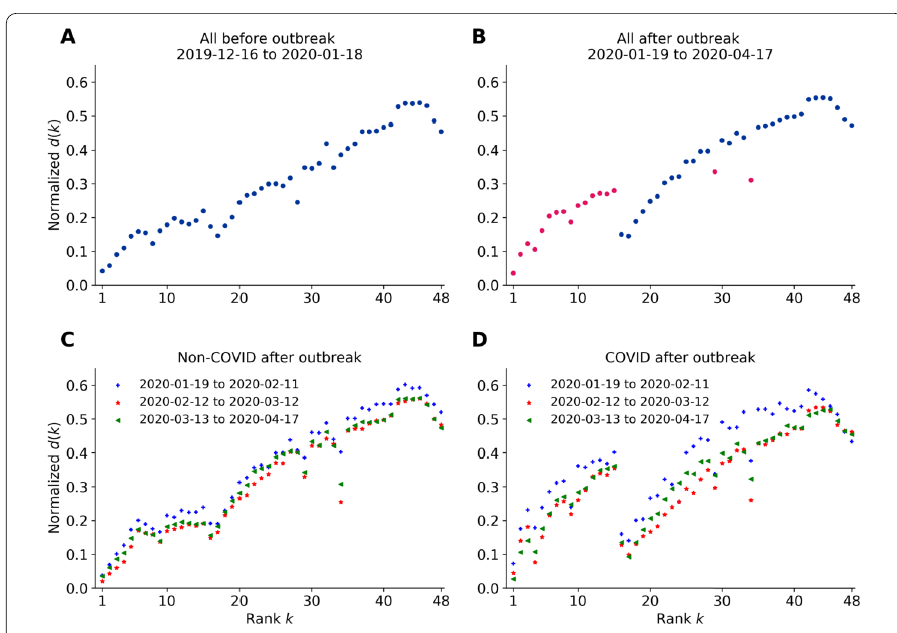
Figure 4 Rank diversity d ( k ) of the 48 ranks on the HSL before and after COVID-19 outbreak. ( A ) Rank diversity taking all hashtags in our observation period before the outbreak, approximately linear except the head and tail parts, with small fluctuations. ( B ) Rank diversity taking all hashtags after the outbreak, with strange points colored in red. A large gap occurs after the top 15th rank. ( C ) Rank diversity taking all non-COVID hashtags in the three periods after the outbreak, strong resemblances with ( A ). ( D ) Rank diversity taking all COVID-hashtags in the three periods after the outbreak. The result in period 1 is higher than period 2 and period 3, revealing a more dynamic change of the hashtags appeared on the HSL. The gap after rank 15 is more severe compared to ( B